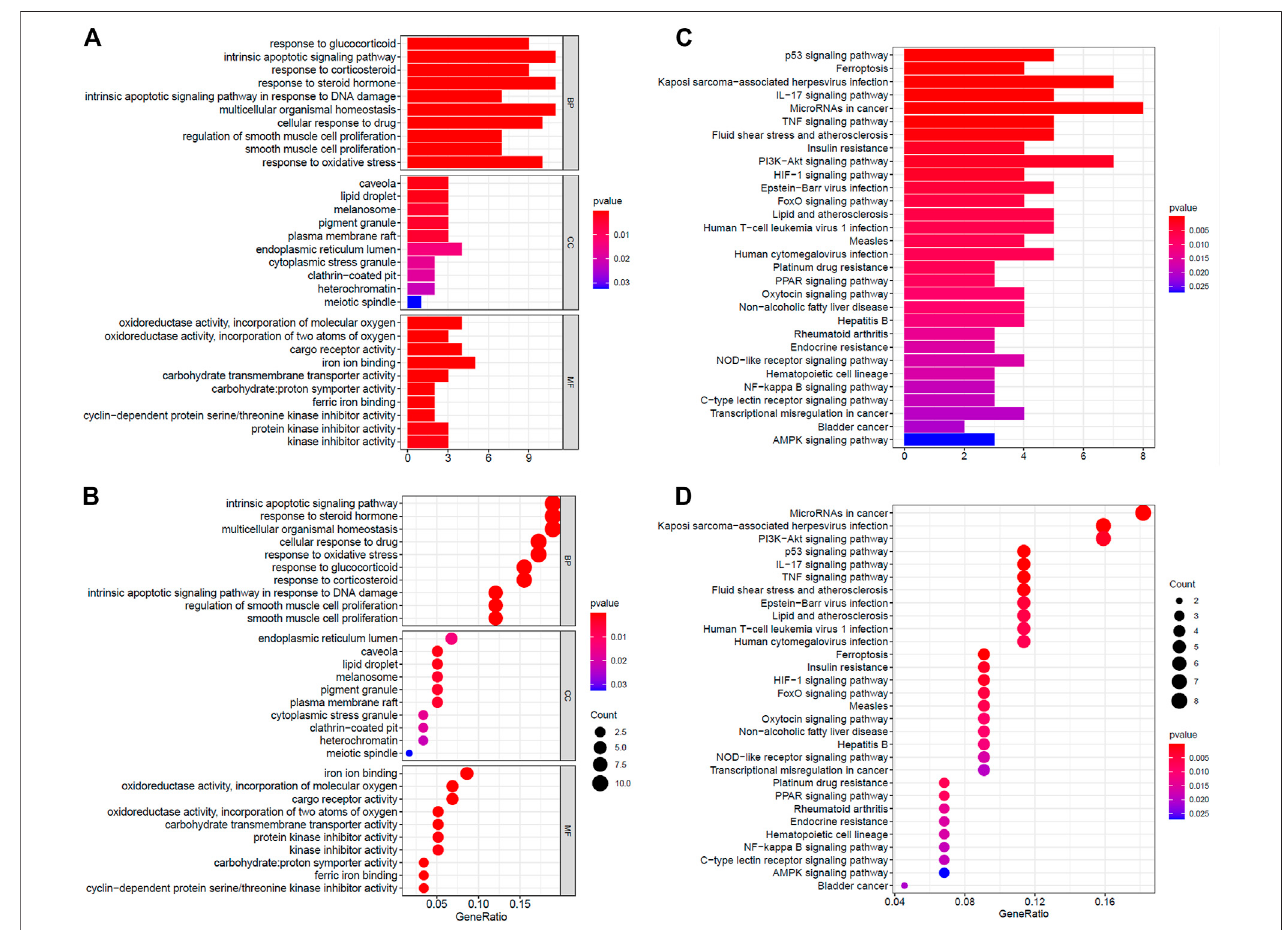
FIGURE2| Functionalenrichmentanalysisofferroptosis-relatedgenes. (A,B) TheGOanalysisofDEferroptosisgenes. (C,D) TheKEGGanalysisrevealedthatDE ferroptosis genes were associated with microRNAs, Kaposi ’ s sarcoma-associated herpesvirus infection, PI3K-Akt signaling pathway, etc.